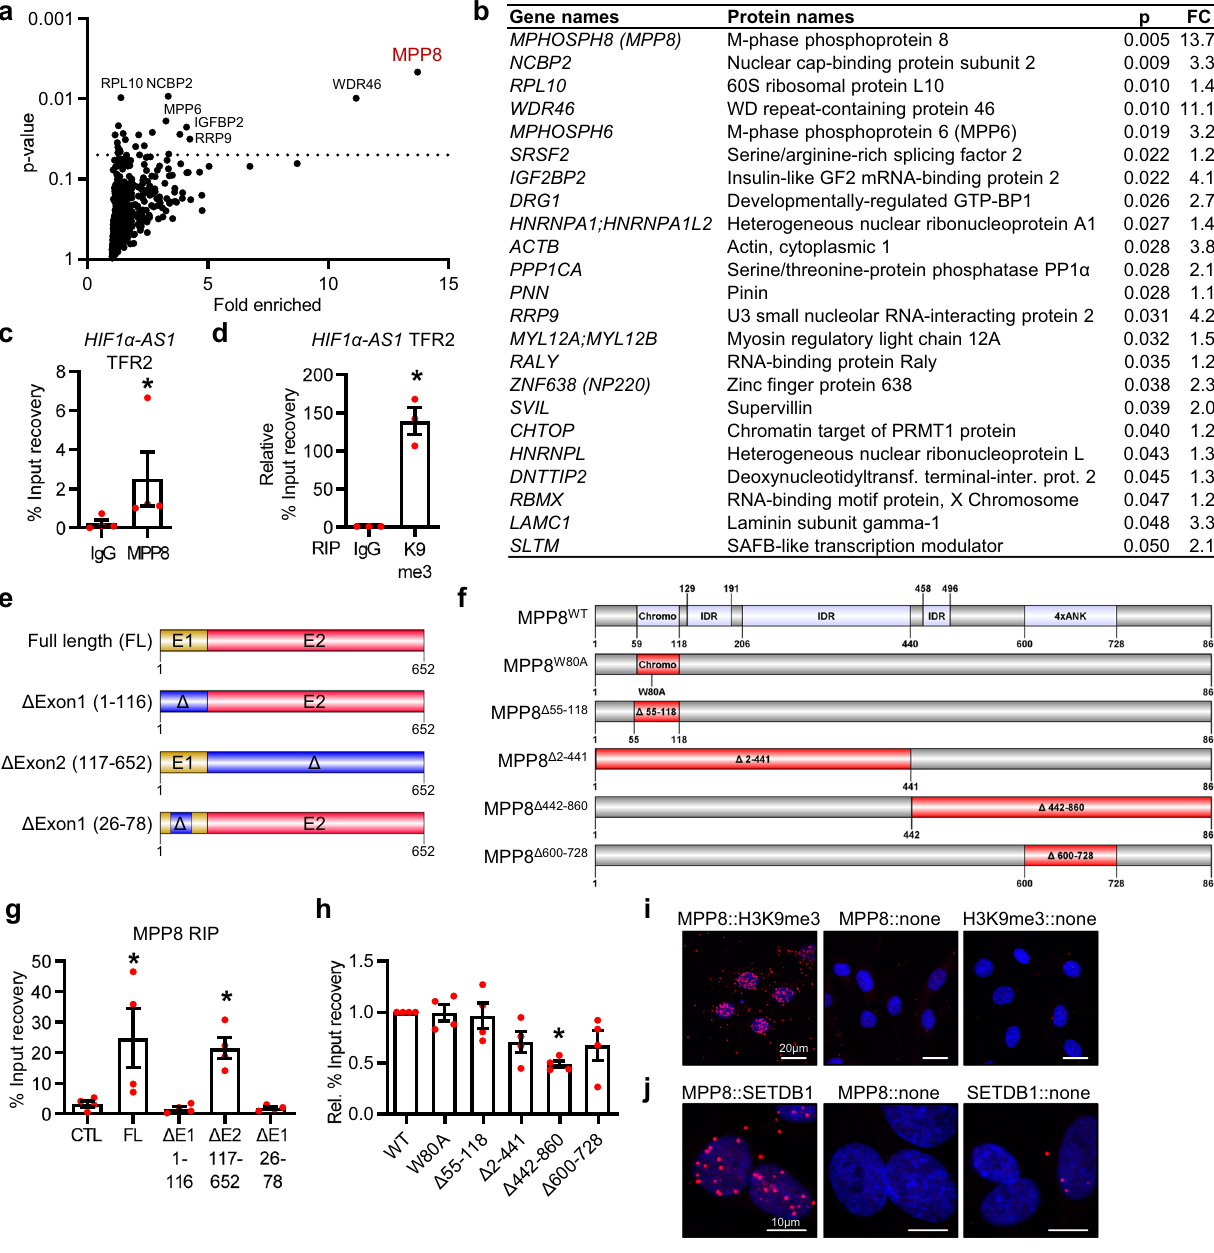
MPP8antibodieswereusedforRNAimmunoprecipitation(RIP).AnT7-MCSinvitro transcribed RNA served as negative control (CTL). FL, full length; E1, Exon1; E2, Exon2. Δ indicates the deleted nt from HIF1 α -AS1 full length. n =4 independent experiments, One-Way ANOVA with Dunnett ’ s test. *FL ( p =0.018), * Δ E2 117- 652 ( p =0.0453). h RT-qPCR after in vitro binding assay of different in vitro trans- latedHis-taggedMPP8mutantswithinvitrotranscribed HIF1 α -AS1 fulllength.Anti- His was used for RNA immunoprecipitation. n =4 independent experiments, One- Way ANOVA with Dunnett ’ s test. *( p =0.0029). i , j Proximity ligation assay of HUVECs with antibodies against MPP8 and H3K9me3 ( i ) or MPP8 and SETDB1 ( j ). The individual antibody alone served as negative control. Red dots indicate poly- merase ampli fi ed interaction signals. Scale bar indicates 20 µ m ( i ) or 10 µ m ( j ). Imageswererepresentative of threeindependent experiments.Dataarepresented as mean